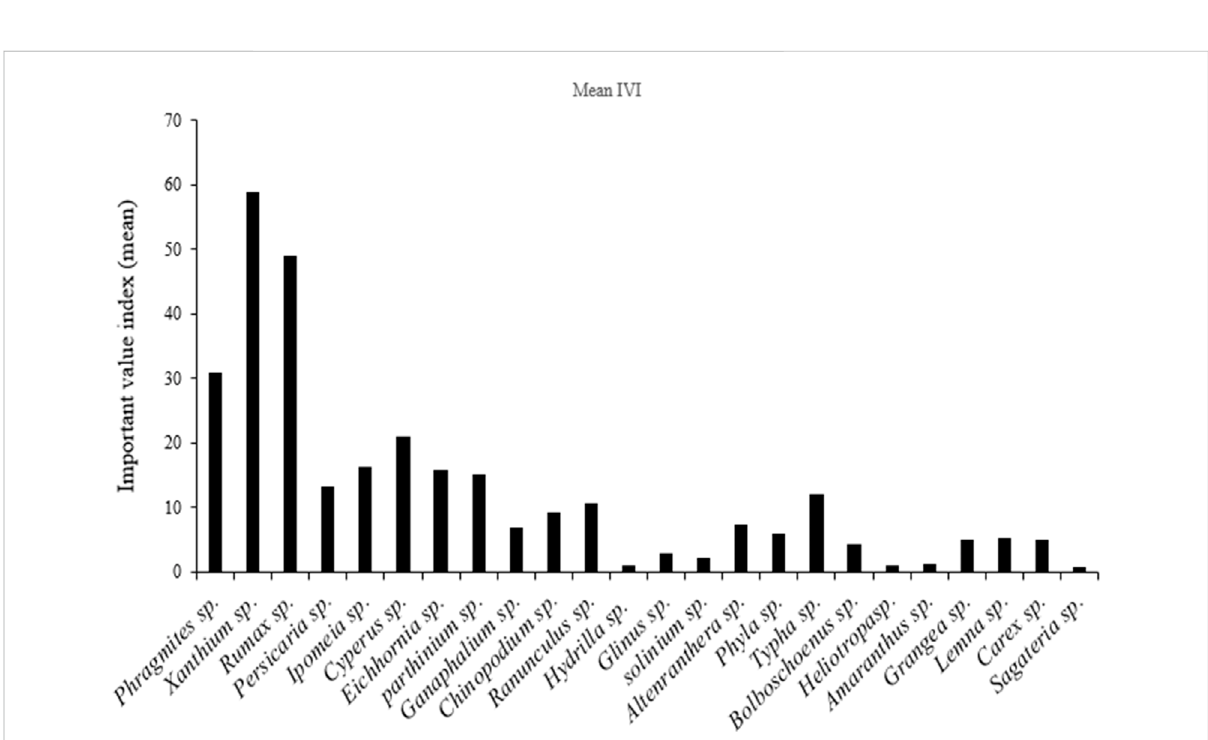
FIGURE 7 Macrophytes with mean Importance Value Index (IVI) recorded at wastewater affected fl oodplain between Antaghat and Kalighat during Nov 2018 to May 2019.